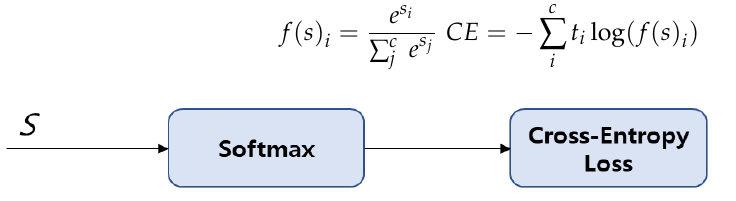
Figure 6. Flow diagram of activating function from ‘Softmax’ .